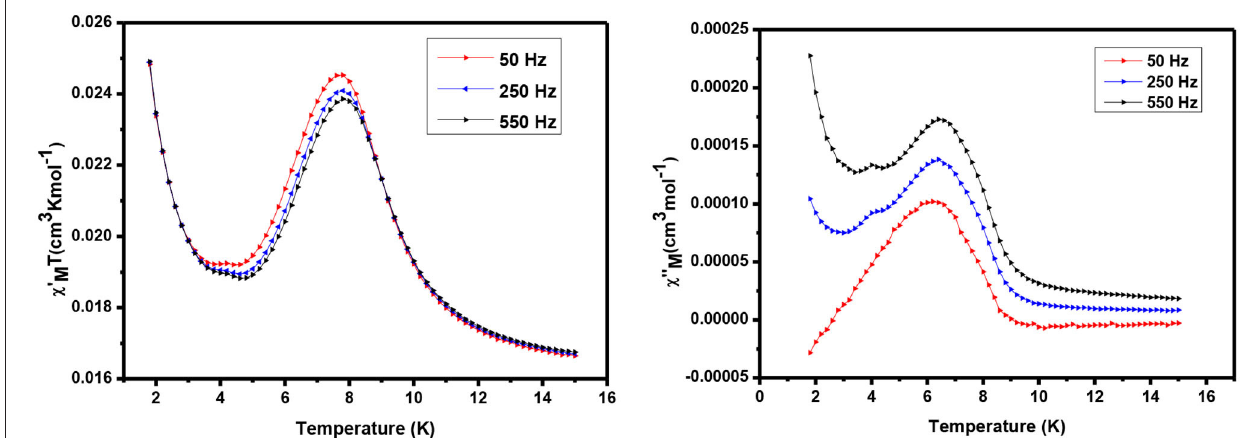
FIGURE 7 | AC susceptibility of complex 1 in phase (Left) and out of phase (Right) .